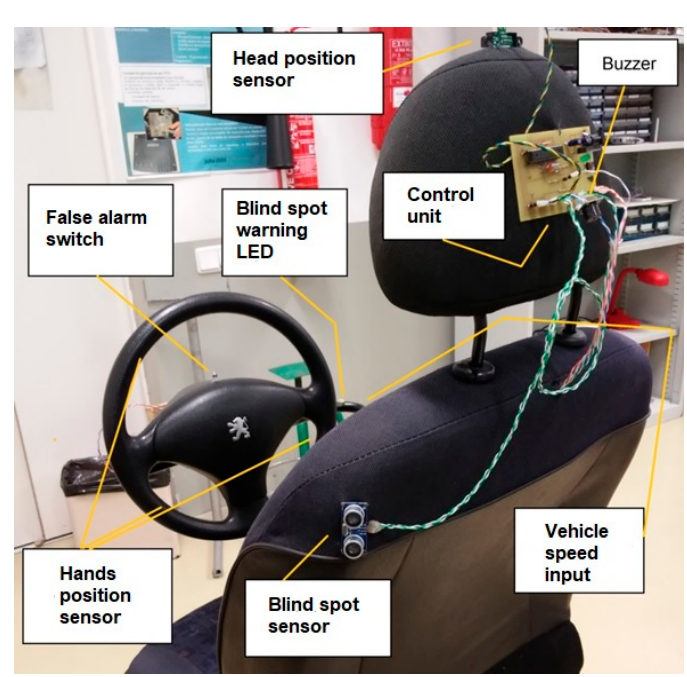
Figure 5. NoSleep prototype lab demonstrator.